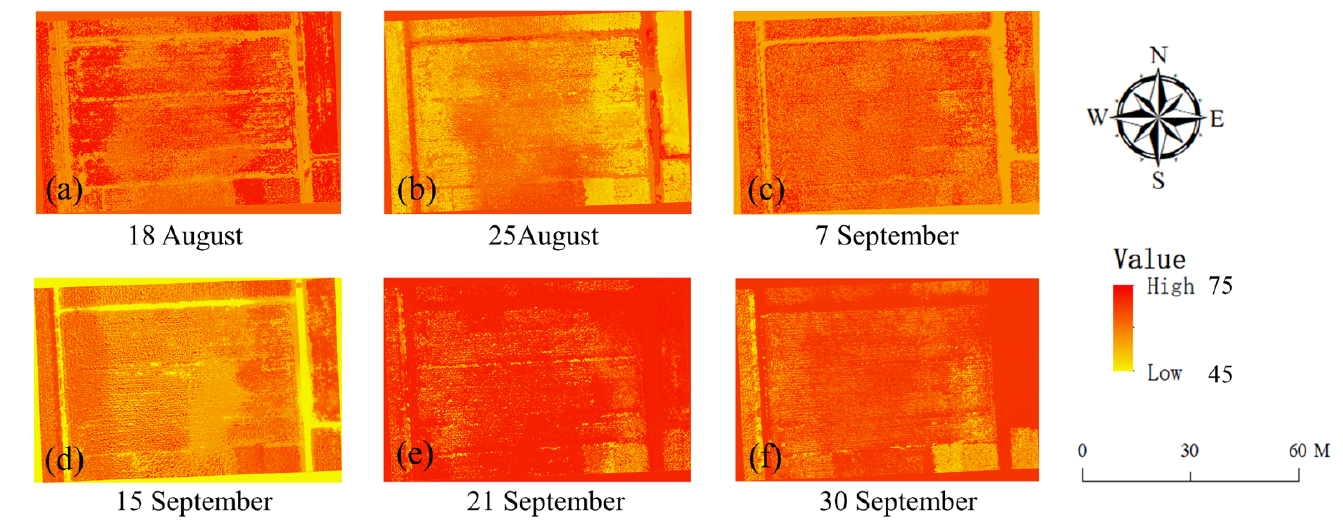
13 of 22 Figure 8. The validation of the support vector machine (SVM) and random forest (RF) methods at different growth stages of maize. Note: Aug represents August, and Sep represents September, re-